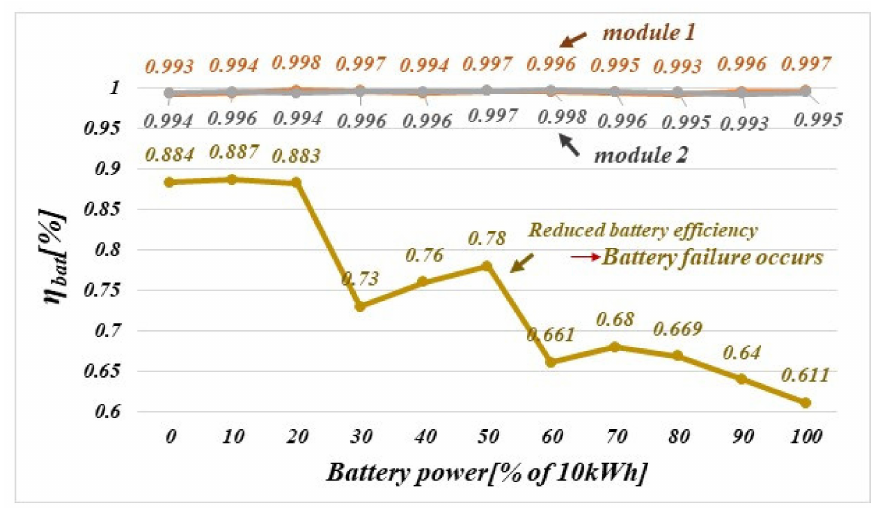
Figure 11. Battery efficiency difference profile graph according to battery power.